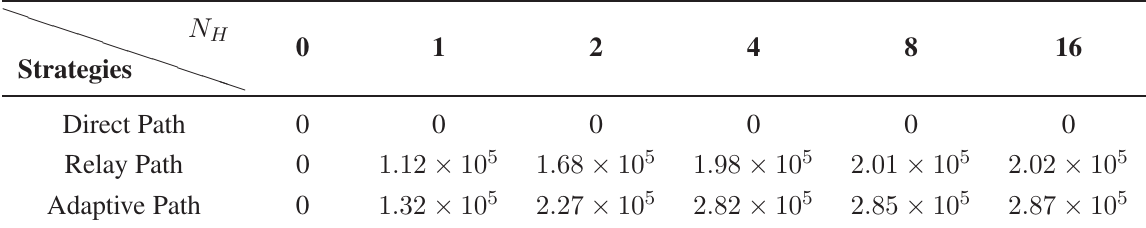
Figure 9. Energy consumption for the direct path, relay paths and adaptive path selection versus the number of HAPs at the source level ( N Table 3. The saving of energy versus the number of HAPs at the system level ( N = 500 , κ = 12 dB , κ = 7 dB T 1 2